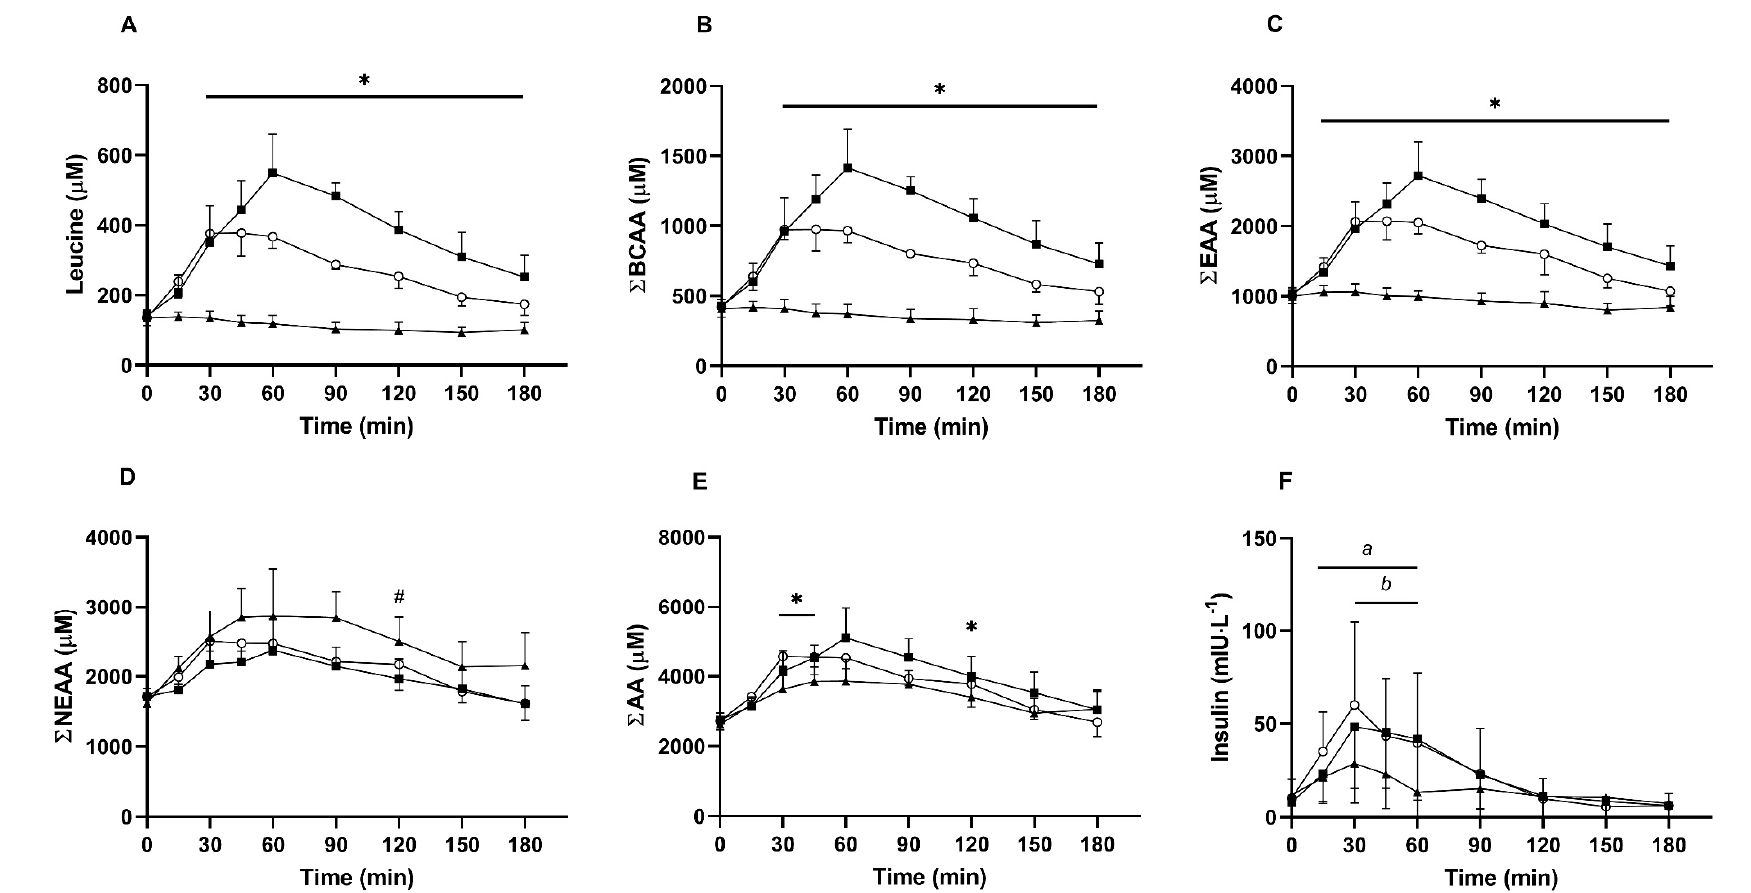
Figure 1. Serum amino acid (( A ): Leucine, ( B ): Sum Branch Chain Amino Acids (BCAA), ( C ): Sum Essential Amino Acids (EAA), ( D ): Sum Non-Essential Amino Acids (NEAA), ( E ): Sum Total Amino Acids (AA)) and insulin concentrations ( F ) in response to non-essential amino acids (NEAA, (cid:78) ), whey protein isolate (WPI, (cid:4) ), and blue whiting protein hydrolysate (BWPH, ○ ) in healthy older adults. Data are presented as mean ± SD. * Significant differences between conditions at each time point (see text for further details); # NEAA significantly higher than WPI; a significantly different to baseline in BWPH; b significantly different to baseline in WPI. (cid:35)